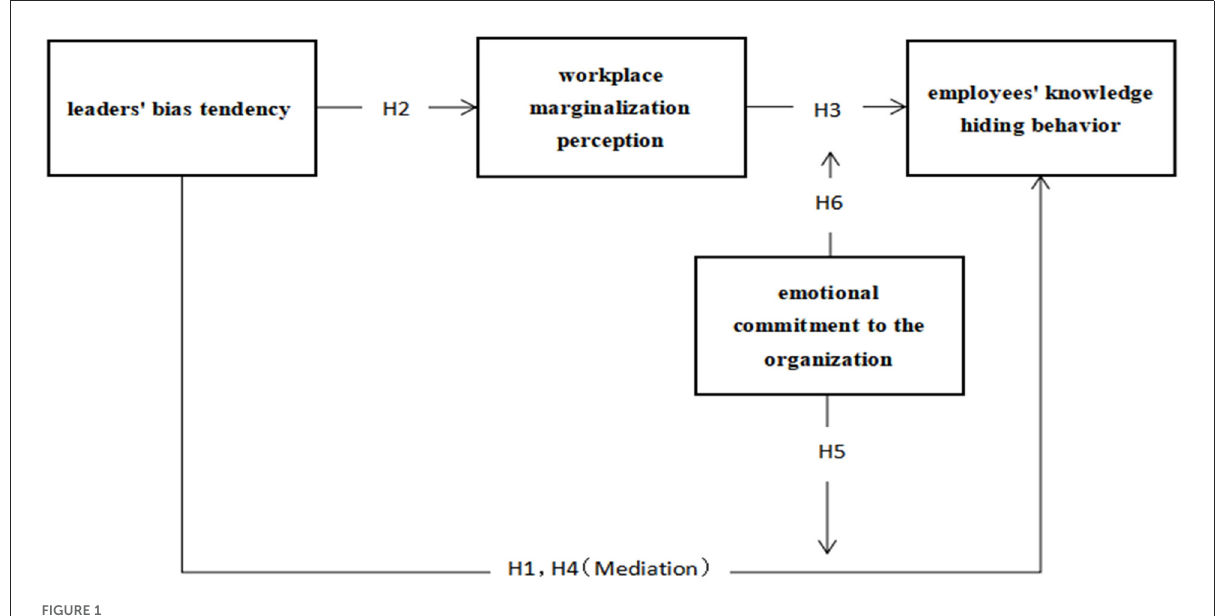
FIGURE1 Research model